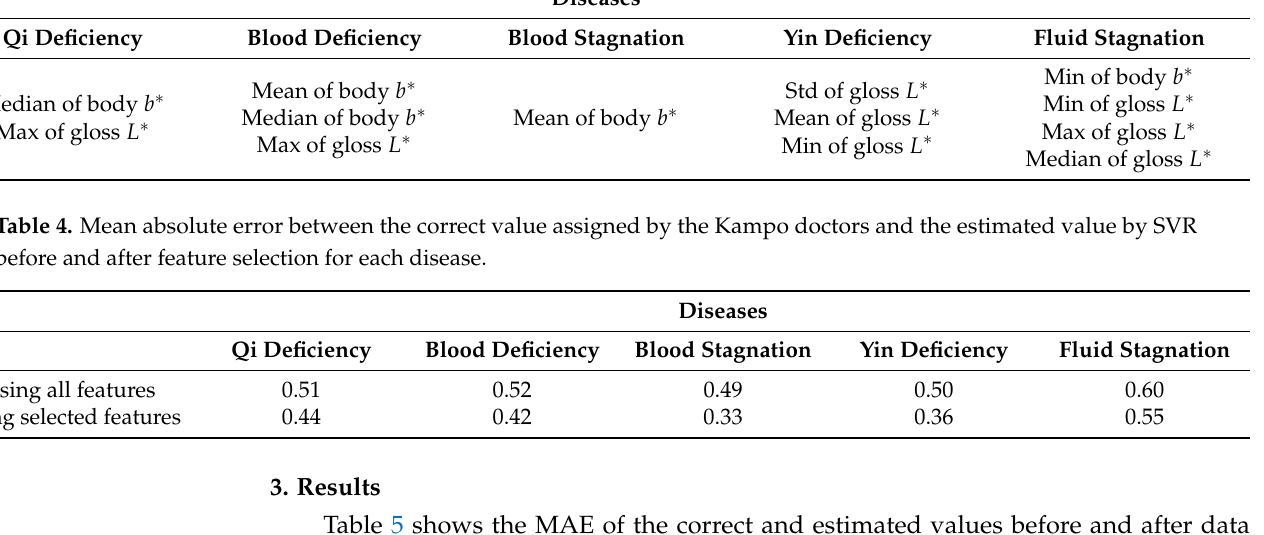
Table 3. Features selected by step-forward selection for each disease. Diseases